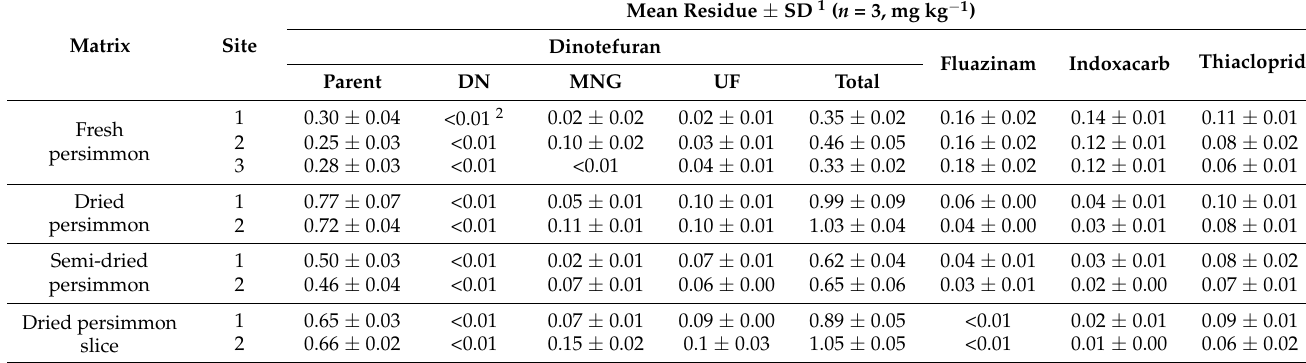
Table 5. Average residue of test pesticides in fresh persimmon and their processed products on harvest day.